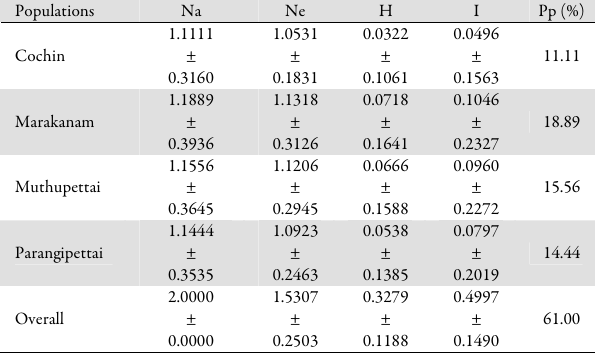
Tab. 2. Overall observed number of alleles (Na), Effective number of alleles (Ne), Gene diversity (H), Shannon's Information index (I), Number of polymorphic loci (Np) and Percentage of polymorphic loci (Pp) in four populations of E . machnata